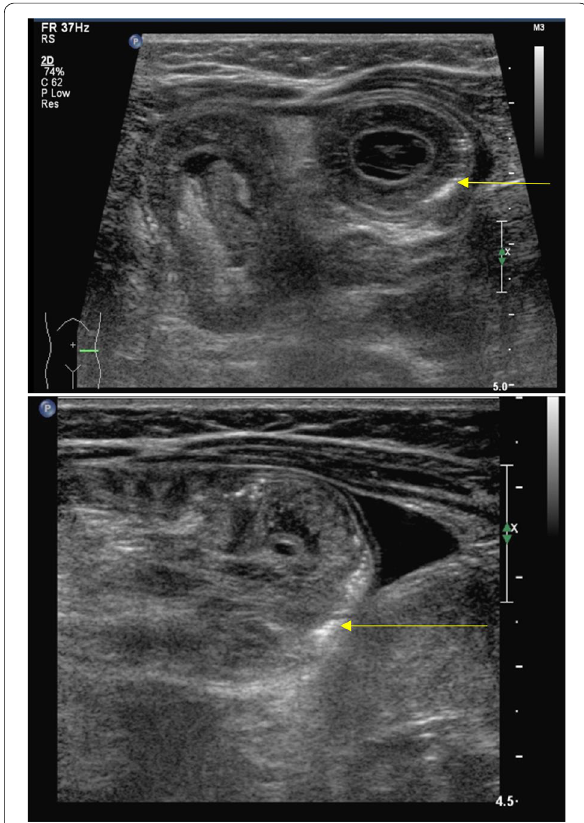
Fig. 1 Abdominal POCUS (over left upper quadrant ): showing intra‑ mural air ( yellow arrow ) in intussusception in a